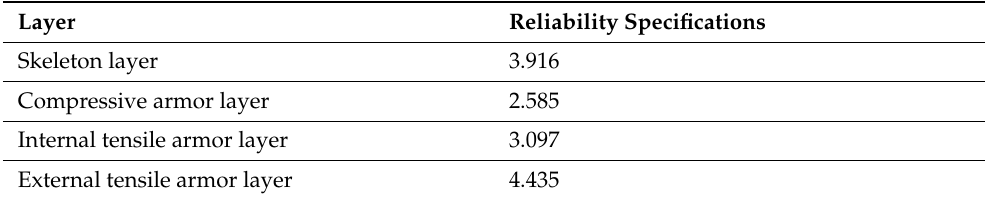
Table 5. Reliability calculation results of the four